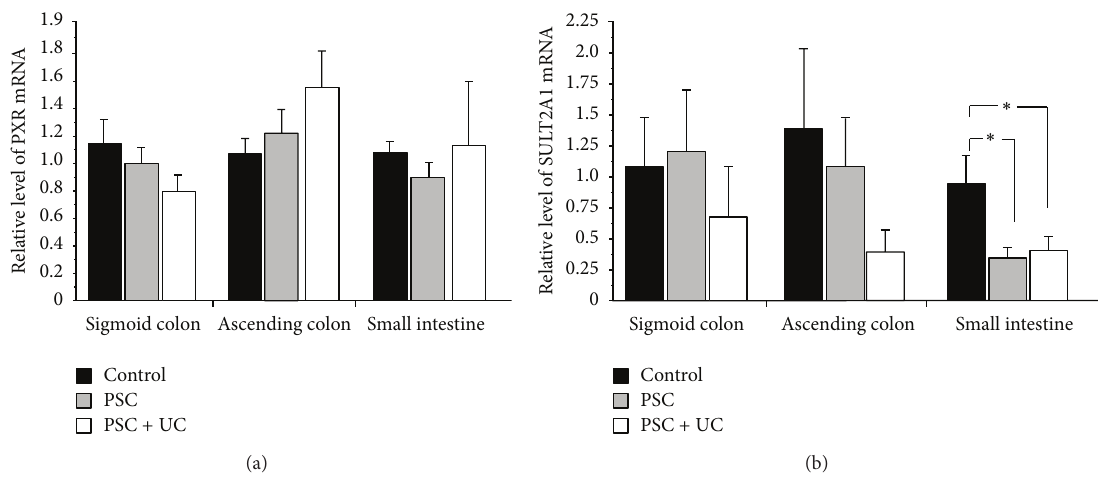
Figure 3: Gene expression of (a) PXR and (b) SULT2A1 mRNA in colon and small intestinal tissues of PSC patients without (PSC) or with ulcerative colitis (PSC + UC). Levels of gene expression presented as fold-change relative to control were normalized with glyceraldehydes 3-phosphate dehydrogenase (GAPDH). Bars indicate the mean ± SEM and ∗ 𝑝 <